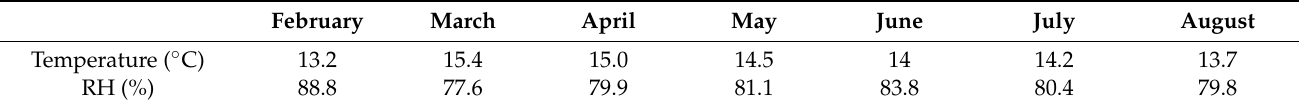
Table 1. Average values of temperature ( ◦ C) and relative humidity (RH, %) at the study site during this